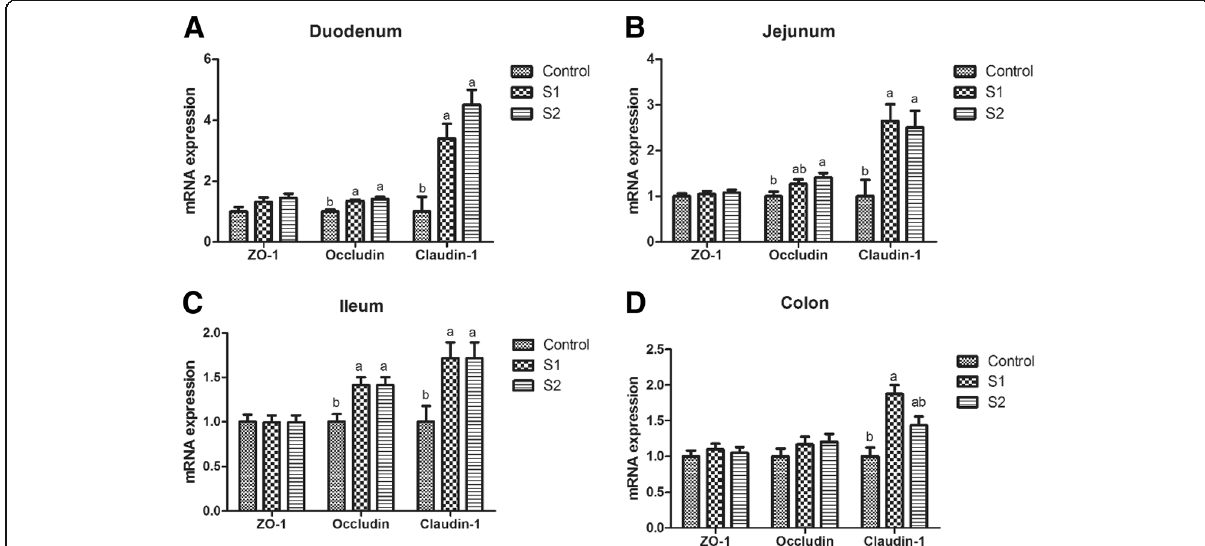
Fig. 4 Effect of gastric infusion of SCFA on the relative mRNA expressions of intestinal tight junction-related genes in duodenum, jejunum, ileum, and colon of weaned piglets. S1, pigs treated with SCFA (acetic, propionic, and butyric acids; 20.04, 7.71, and 4.89 mM respectively); S2, pigs treated with SCFA (acetic, propionic, and butyric acids; 40.08, 15.41, and 9.78 mM respectively). a, b, means without a common superscript differ ( P < 0.05)